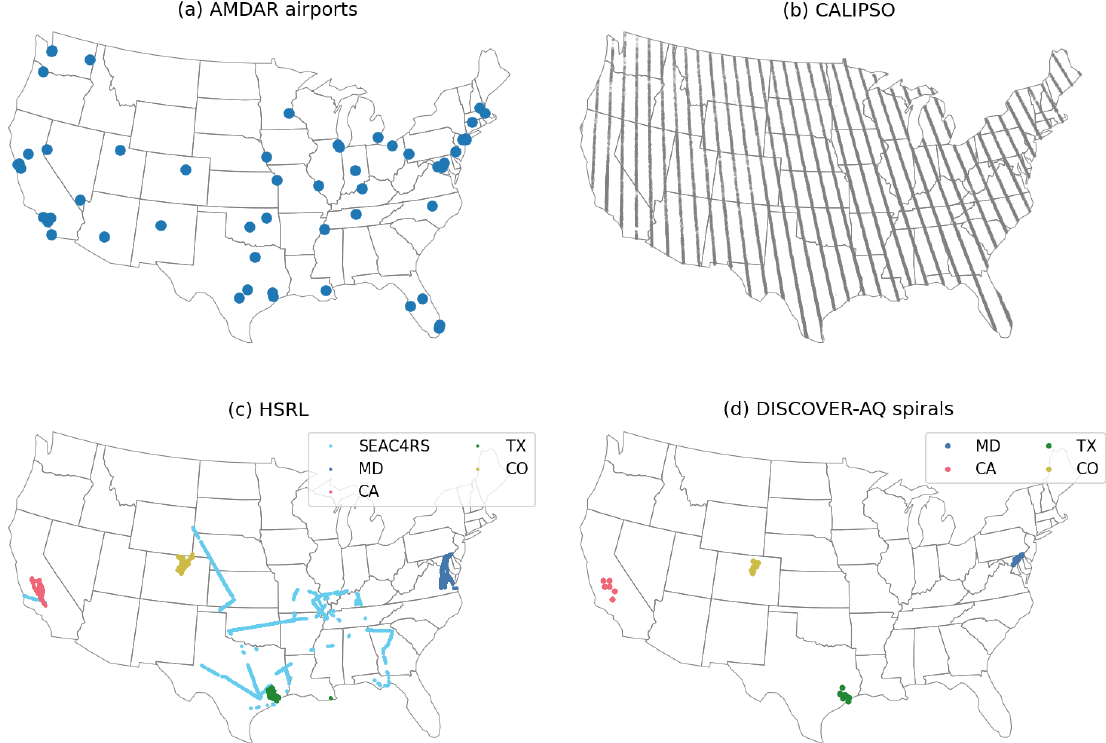
Figure 1. Overview of the locations of the main source of the AMDAR PBLH observation dataset (a) and the three independent validation datasets from the CALIPSO spaceborne lidar (b) , the HSRL airborne lidar (c) , and in situ aircraft spiral profiling during the DISCOVER-AQ campaigns (d) . The HSRL and spiral-profile data were limited to 12:30–14:30LST only, and the CALIPSO overpasses were always at around